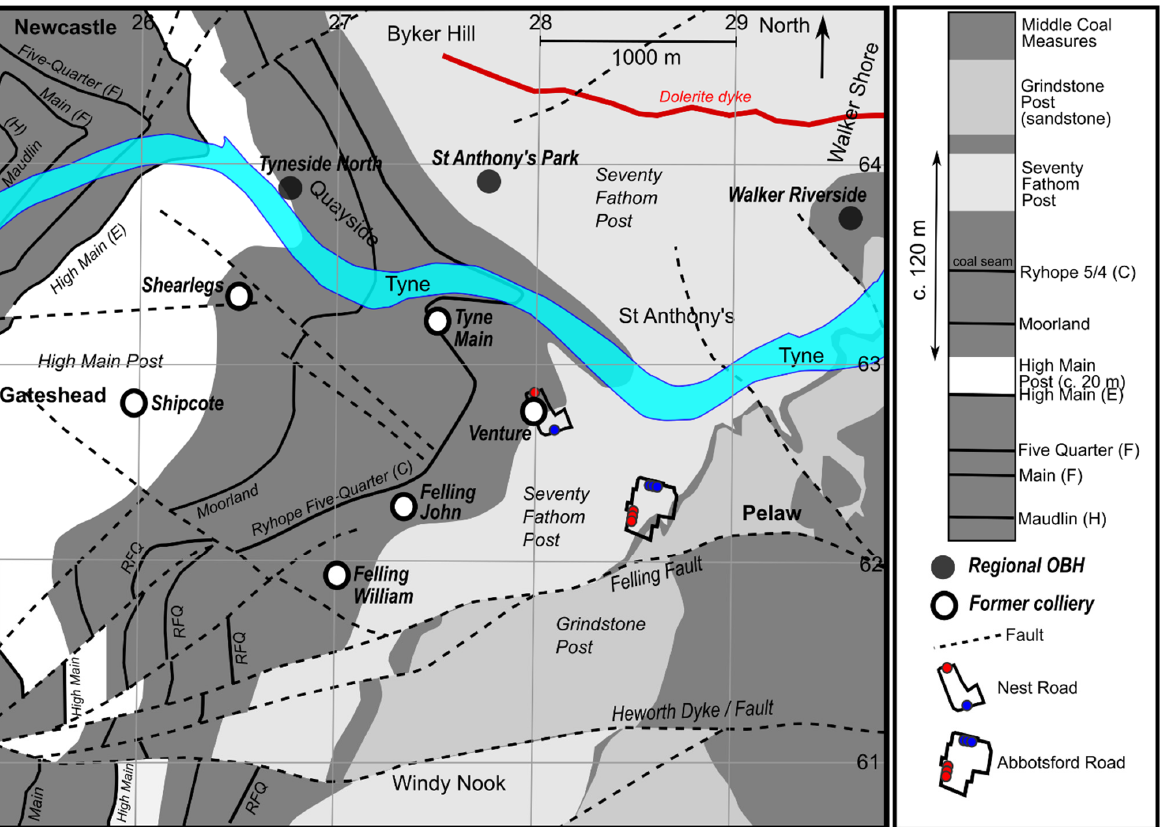
Figure 1. Simplified geological map of the Felling area, showing regional Observation Boreholes (OBH). Geological information derived from British Geological Survey (https://www.bgs.ac.uk/, accessed on 25 November 2021) mapping. Contains Open Geoscience public sector information licensed under the Open Government Licence v3.0.